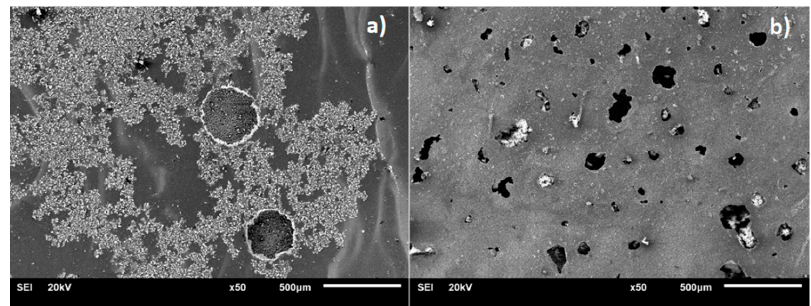
Figure 13. SEM images of corrosion damage formed on ( a ) nitrided and ( b ) carburized Ti6Al4V alloy samples as a result of potentiodynamic polarization.